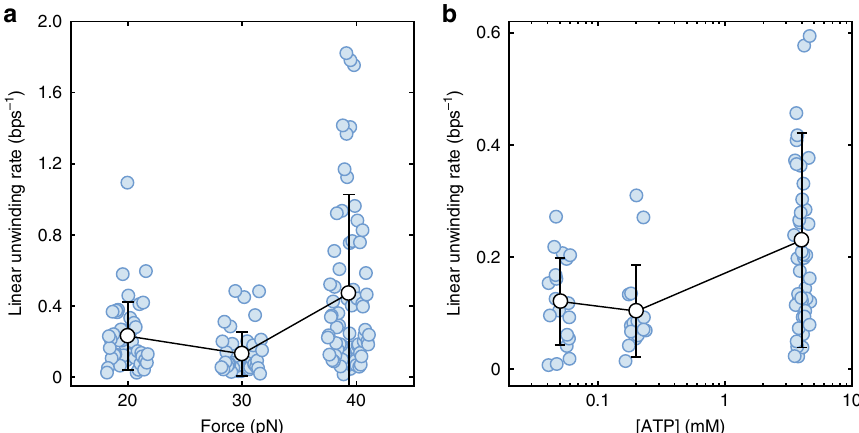
Fig. 2 Mean linear DNA unwinding rate by CMG as a function of force and ATP concentration. a Forces of 20.0, 30.0, and 39.3 pN applied to the linear duplex through the lagging-strand template varies the unwinding rates and distribution with increases at high forces. b ATP concentrations of 0.05, 0.2, and 4 mM varies the unwinding rates and distribution with increasing ATP having higher rates. Error bars are standard